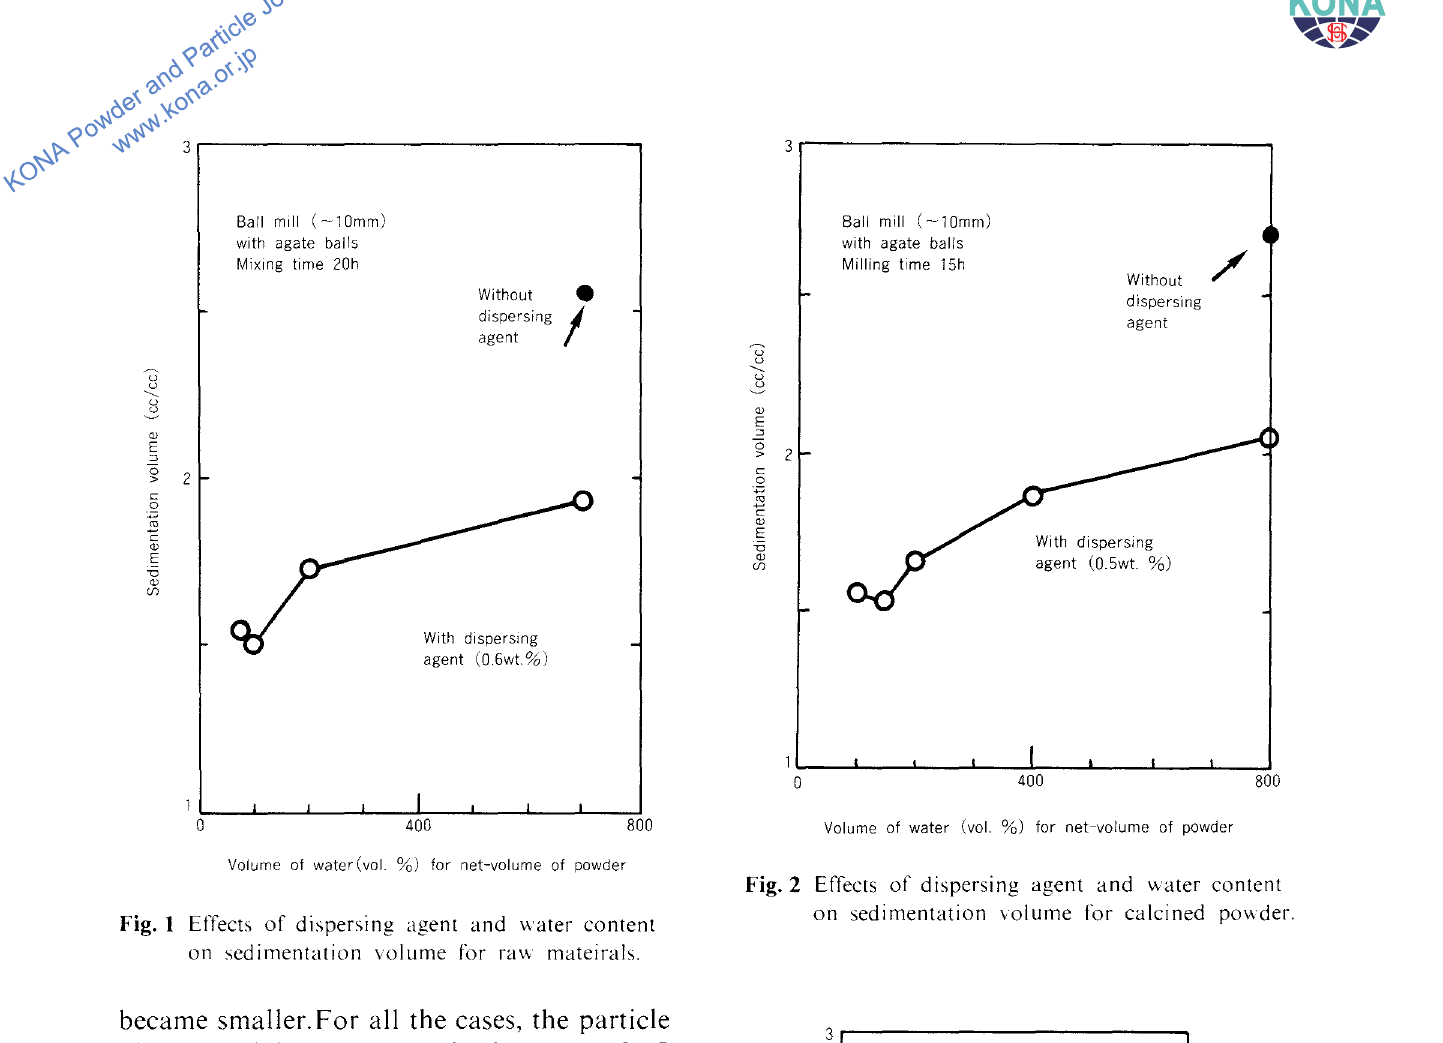
Fig. 1 Effects of dispersing agent and water content on sedimentation volume for nm mateirals.